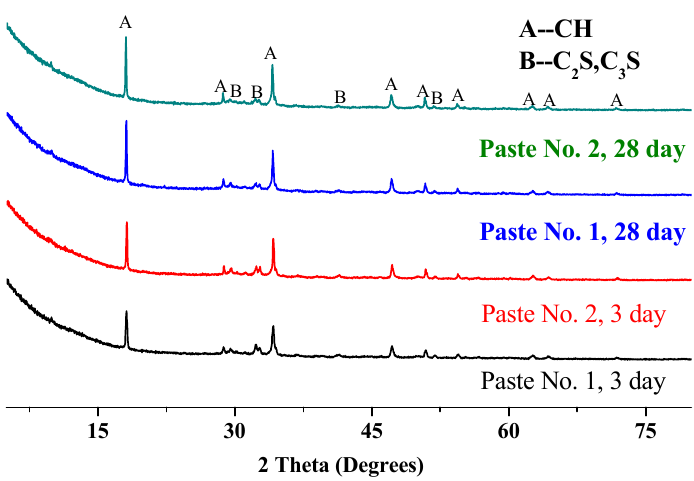
Figure 5. X-ray diffraction (XRD) pattern of pastes (No. 1 and No. 2).